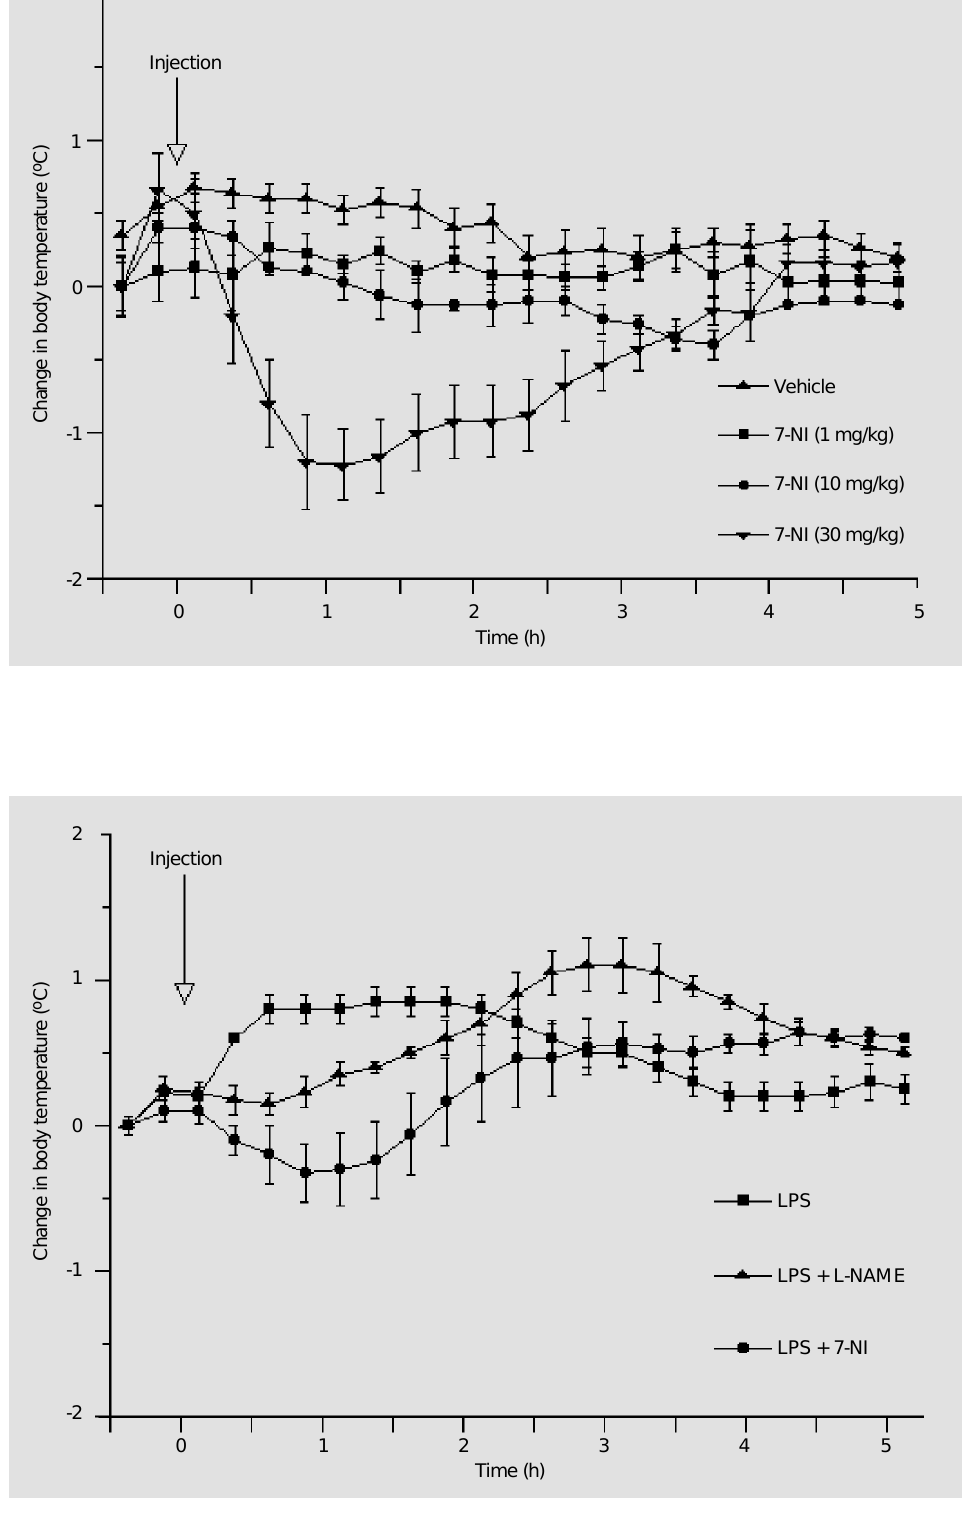
mined at 15-min intervals rela- tive to baseline. N = 5 in each group.